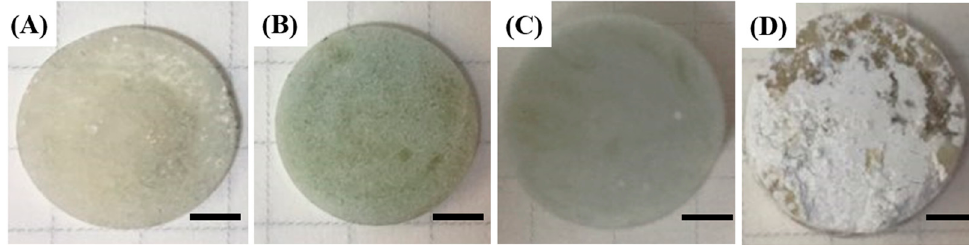
Figure 4. Representative optical images of poly(methyl methacrylate) (PMMA)/HA composites produced using the HA microspheres with various HA contents of ( A ) 5 vol %; ( B ) 20 vol %; ( C ) 40 vol %; and ( D ) composite produced using the HA powders with an HA content of 20 vol % (Scale bar = 3 mm).